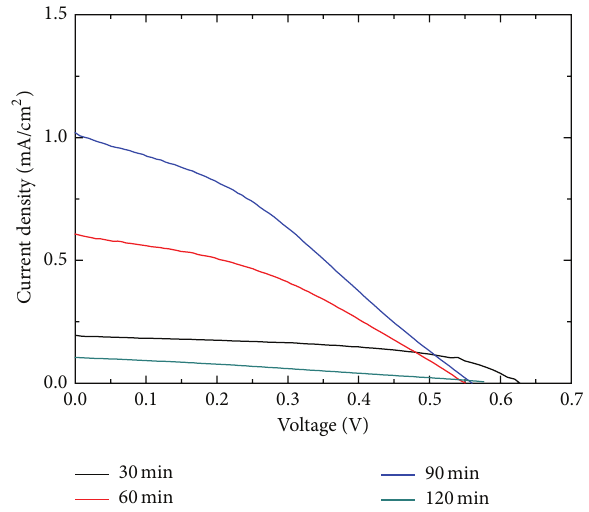
Figure 4: J-V characteristic of DSSCs with the ZnO nanowires grown for different time.